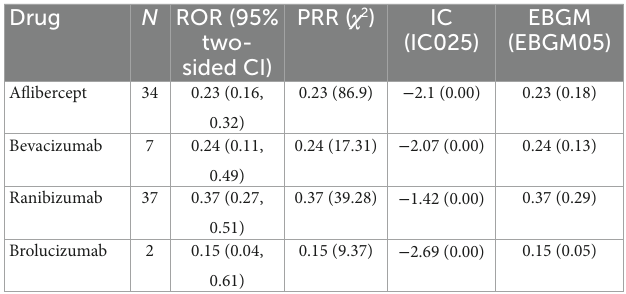
TABLE 3 Association of different intraocular anti-VEGF regimens with renal